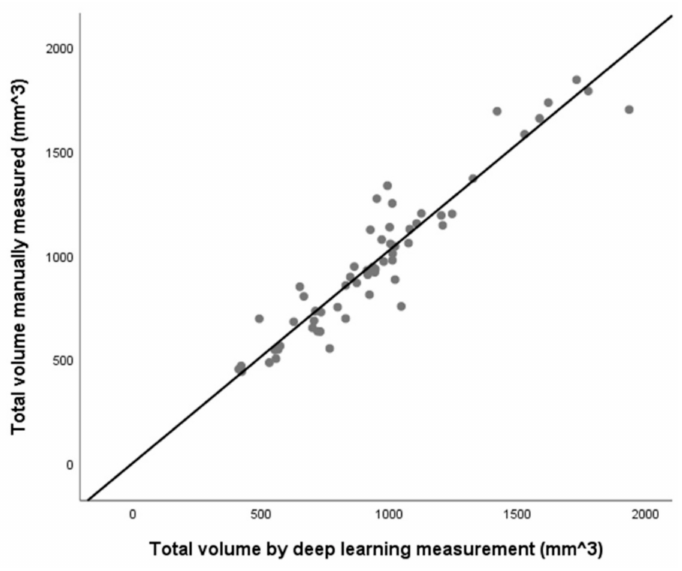
Figure 5. Scatter plot of total volume measured between the manual of deep learning (r 2 = 0.975, slope = 1.02, p < 0.001). The line indicates a linear regression graph. There is a strong correlation between the two methods (N =